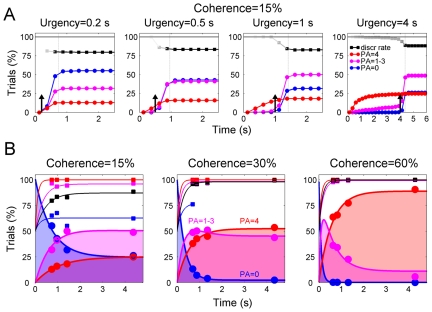
Cumulative frequency of PA scores over time (A) and visibility curves (B).A: Trials were subdivided in full visibility trials (PA = 4, red), intermediate visibility trials (PA = 1–3, magenta), and blind trials (PA = 0, blue). Time zero is motion onset. The curves with the squares represent the instantaneous motion discrimination rate, where the grey tone maps linearly the number of trials (total cumulative frequency distribution; white  =  no trials, black  = 100%). The vertical dotted lines indicate the moment at which the total cumulative trial frequency reached 95%, at which time the value of each cumulate frequency of PA scores was sampled to build the visibility curves illustrated in panel B. The short vertical arrows indicate the disappearance of the fixation dot (imperative cue) at each urgency condition. Data from all observers were pooled together. Bin width  = 250 ms. B: Visibility curves. Temporal evolution of the frequency of the three classes of PA scores (circles and thick curves). Also plotted is the time-course of discrimination rate for each class (squares and thin curves). The fitted curves for null and full visibility trials were obtained with a 3-parameters exponential function, while the curves for intermediate visibility were obtained by subtracting from 100 the sum of the instantaneous values of the functions of null and full visibility trials, so that the total instantaneous probability was always 1. We assumed that at the time of stimulus onset the blind trials would represent the totality of the potential responses (100%), with both the intermediate and full visibility trials being absent (0%). The fitted curves for the discrimination rate were obtained with a 2-parameters exponential function, under the assumption that at the time of stimulus onset the discrimination rate would be at chance (50%). The discrimination rate was computed only when the number of trials on which it was based was >10% of the trials in each urgency condition. The fitting models served only descriptive purposes. Time zero represents stimulus onset. Data from all observers are pooled together.